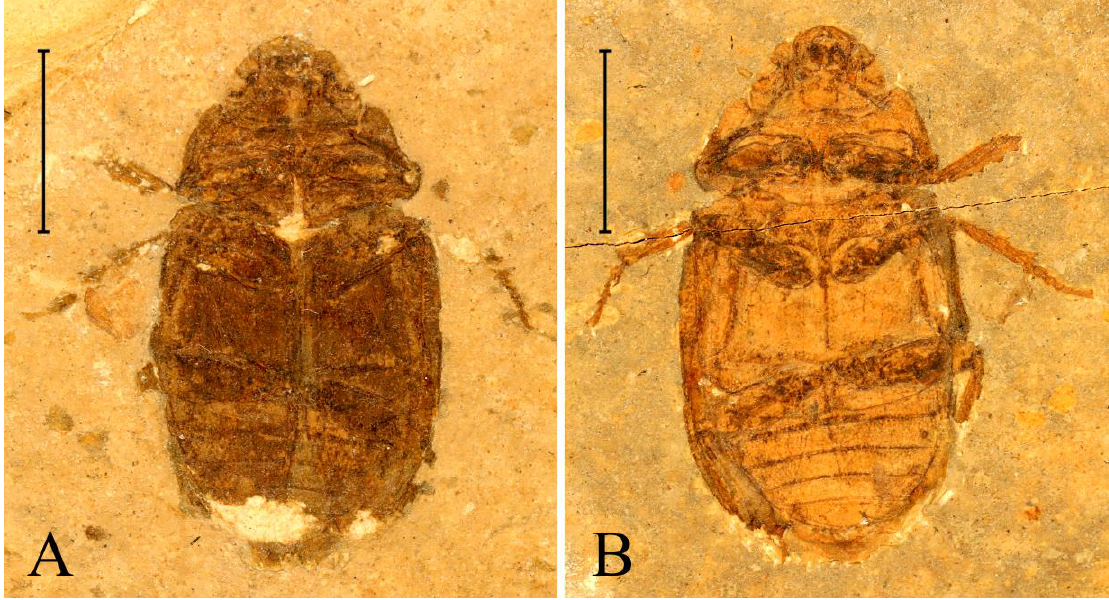
Figure 2. Habitus of Prolucanus beipiaoensis gen. et sp. nov. (holotype, NIGP 176633). ( A ) part; ( B ) counterpart. Scale bars = 5